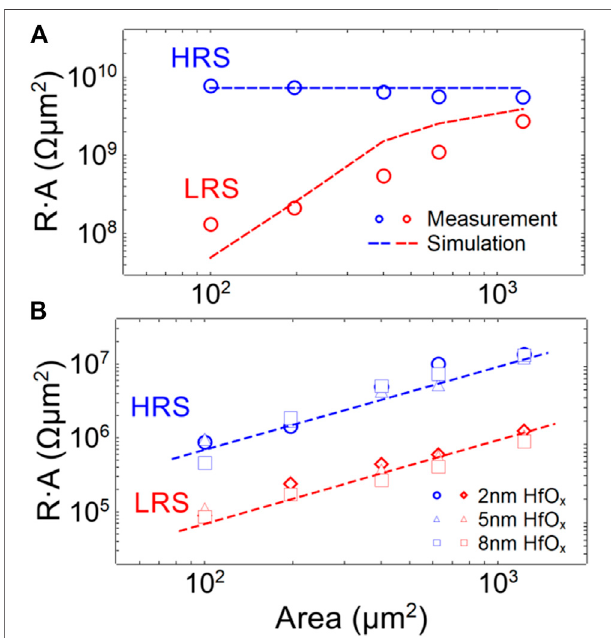
FIGURE 7 | The R · A product as a function of the device active area for (A) type R and (B) type F. The dashed lines present simulated device models. (A) The R · A product showed a constant behavior in HRS for type R, while an area dependent behavior for type F (B) . The area dependency of the R · A product in LRS for device R (A) was caused by the area dependency of the ion drift constant, which was in good agreement with the simulation